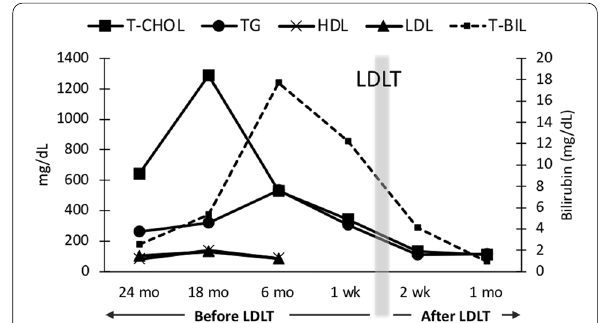
Fig. 1 Chronological changes in parameters. LDLT living donor liver transplantation, T-CHOL total cholesterol, TG triglycerides,